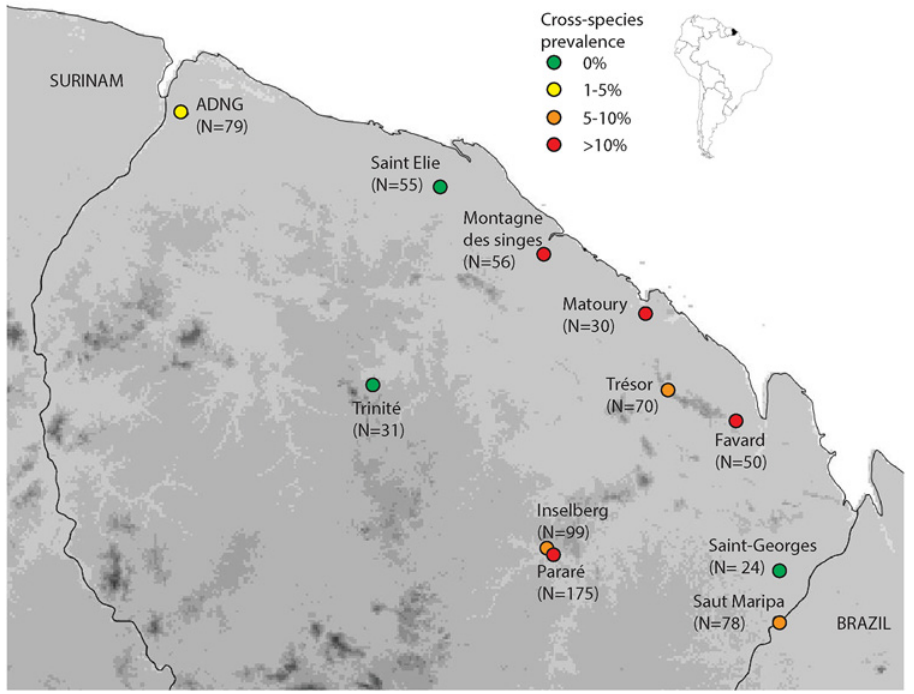
Fig 1. Location of the 11 sites surveyed in 2011 – 2012. Bd -negative sites are indicated with green circles and Bd -positive sites are indicated either in yellow (1 – 5% cross species prevalence), orange (5 – 10% cross species prevalence) or in red ( > 10% cross species